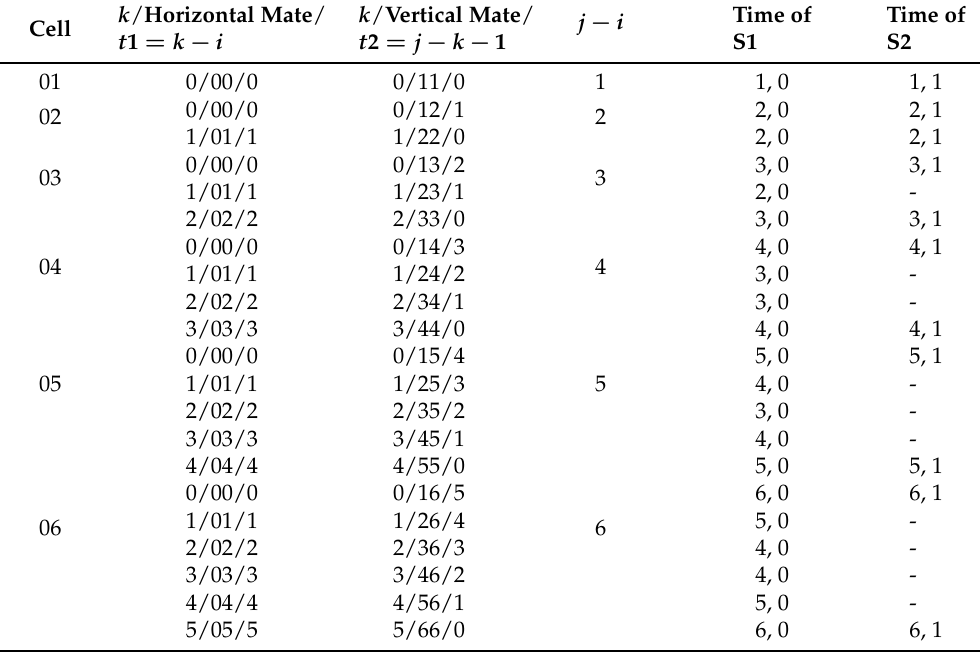
Table 1. Time units t 1, t 2 and the time units of completing S1, S2 for cells 01 to 06; i ≤ k < j . k / Horizontal Mate / Cell